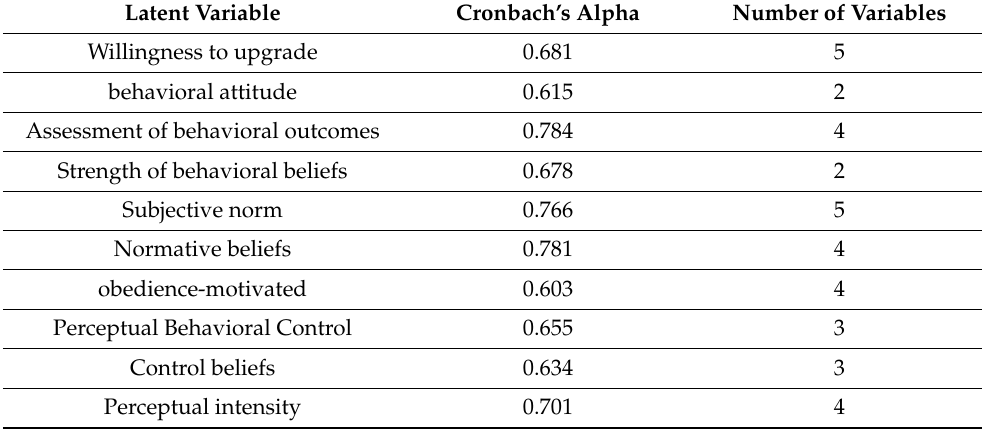
Table 2. Reliability tests for latent